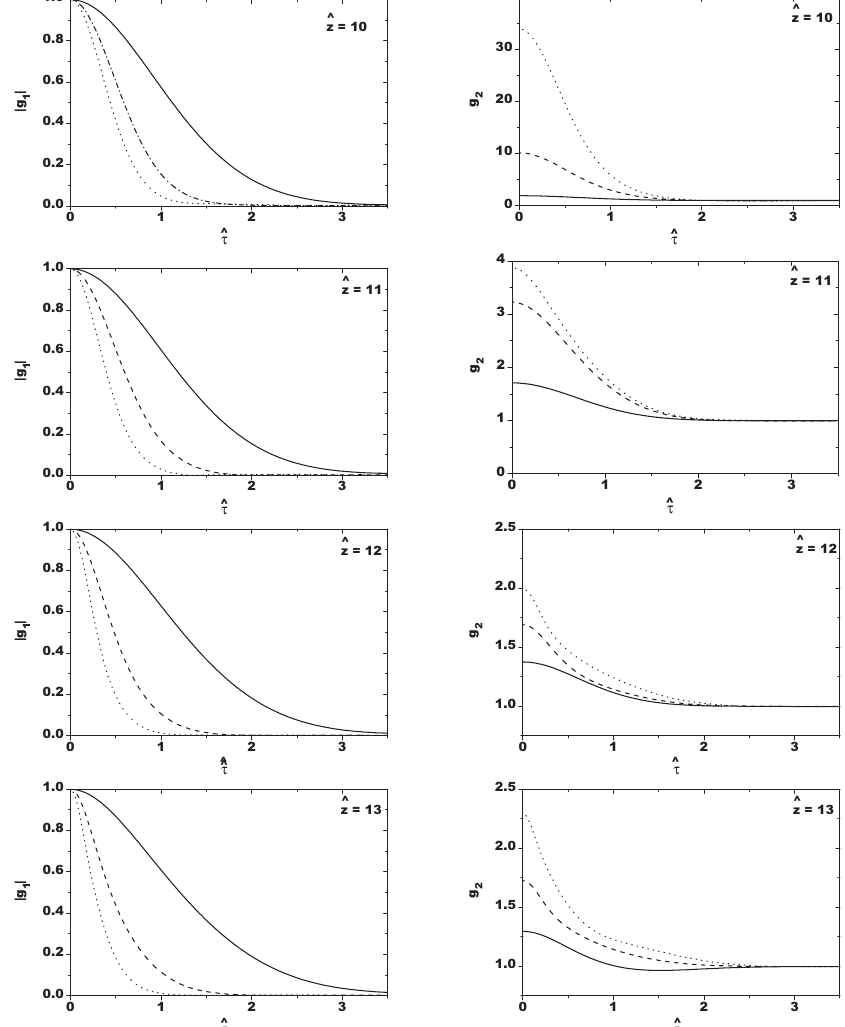
FIG. 8. First (left column) and second (right column) order correlation function at different lengths of the FEL amplifier ^ z (cid:3) 10 – 13 . Solid, dashed, and dotted lines correspond to the fundamental, 3rd, and 5th harmonic,